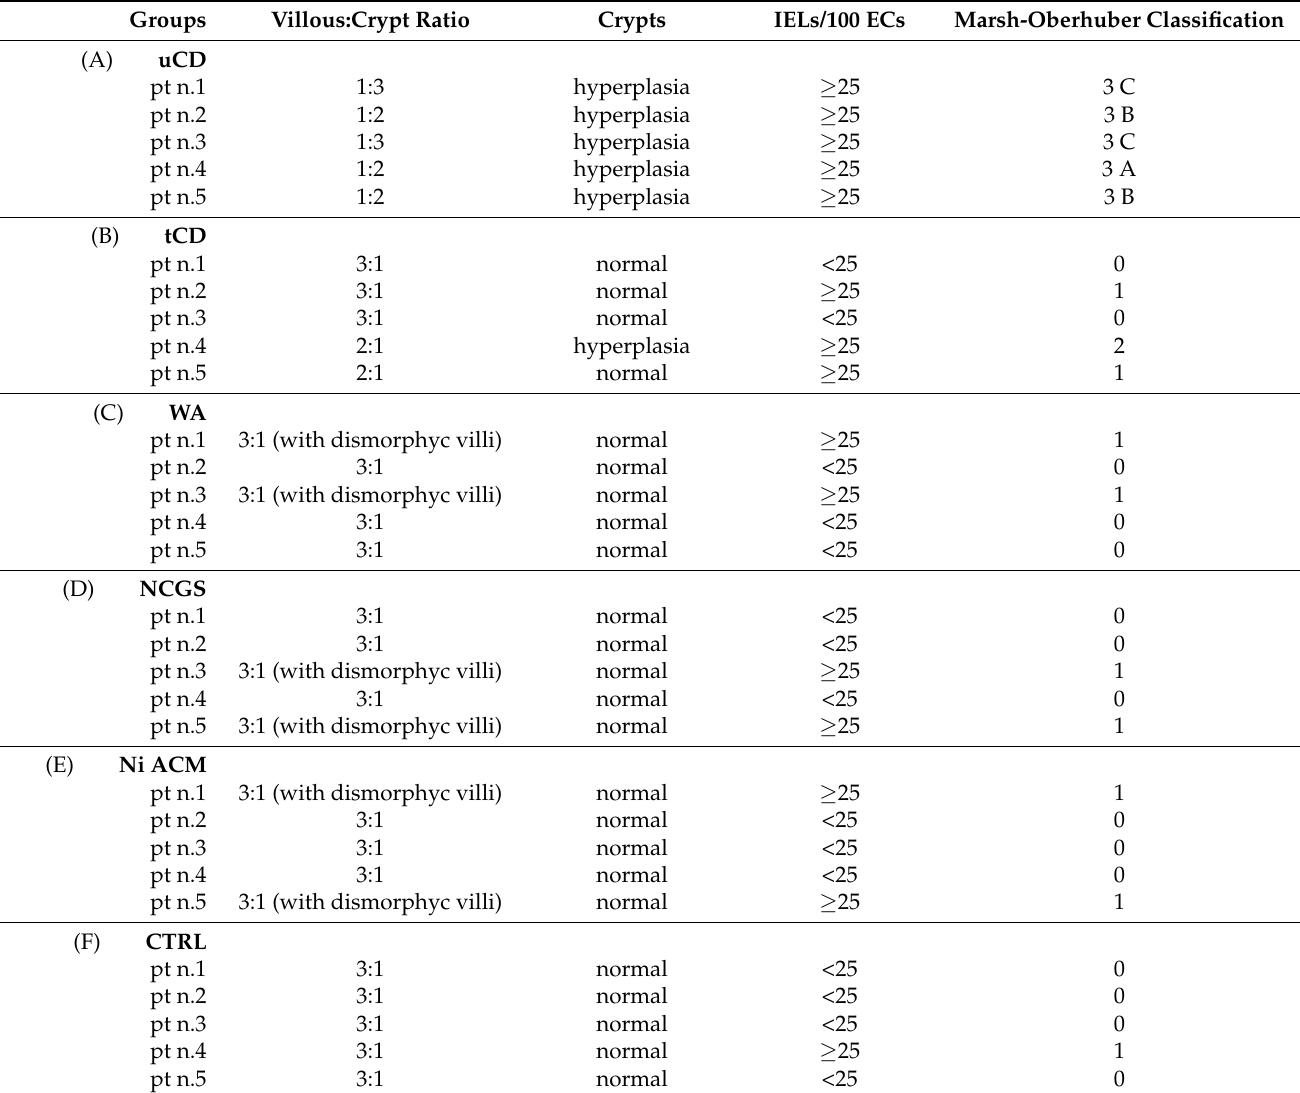
Table 1. Morphological evaluation by light microscopy of duodenal biopsies in IBS-like patients.